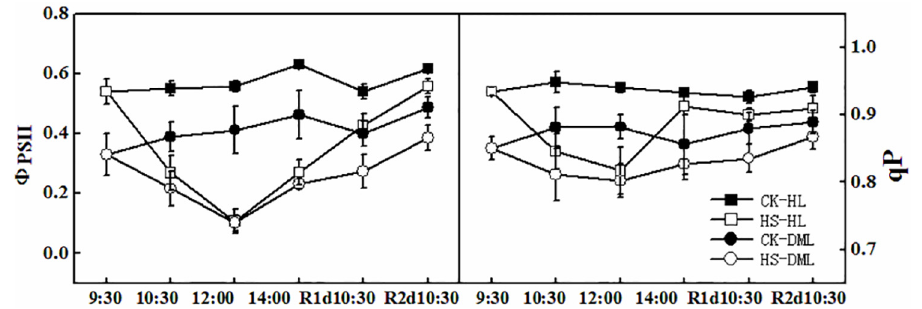
Fig 3. Effects of heat shock and recovery on the actual photochemical efficiency ( Φ PS II ), photochemical quenching coefficient (qP), apparent photosynthetic electron transport rate (ETR), and non-photochemical quenching coefficient (qN) in leaves of healthy and downy mildew-infected cucumber. The data represent the mean ± SE (n = 5).